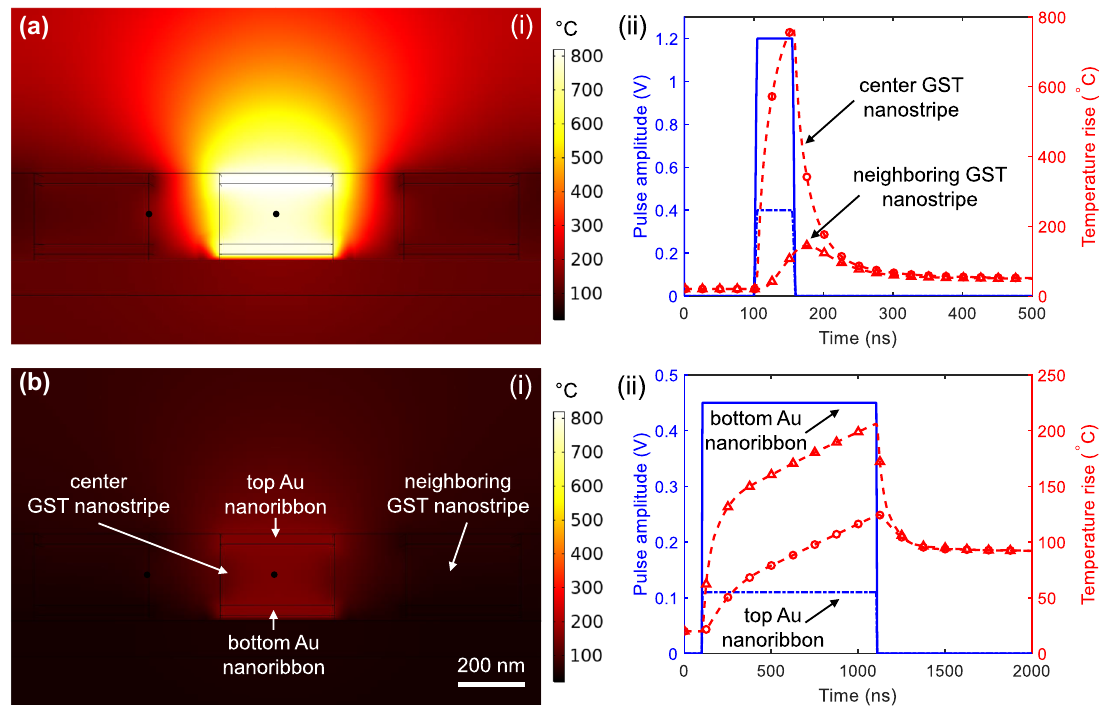
Figure 8: Simulated electrothermal model for the metasurface with a 1D array of hybrid meta-atoms comprising two stacked gold nanoribbons (as nanoheaters) incorporating a GST nanostripe. The bottom nanoribbon is isolated from the AU back-reflector using a 20 layer. (a) Simulated temperature distribution at the cross section of the meta-atoms (i.e., black dot) at the end of the (a, i) nm-thick SiO 2 amorphization pulse (i.e., 150 ns) and (b, i) full crystallization pulse (i.e., 1100 ns). Transient temperature profiles in the center of the middle GST nanostripe as well as on the wall of the neighboring meta-atom upon applying the (a, ii) amorphization and (b, ii) full crystallization pulse. While the whole middle meta-atom in (a) is successfully melted (heated above 630 ◦ C) followed by a quenching process (with the high cooling rate of > 10 ◦ C/ns), the maximum temperature experienced by the neighboring meta-atoms is below the glass transition temperature (i.e., ∼ 160 ◦ C). As shown in (b, ii), the temperature of the neighboring meta-atoms does not go above the glass transition temperature at the end of the crystallization pulse. This ensures addressability at the meta-atom